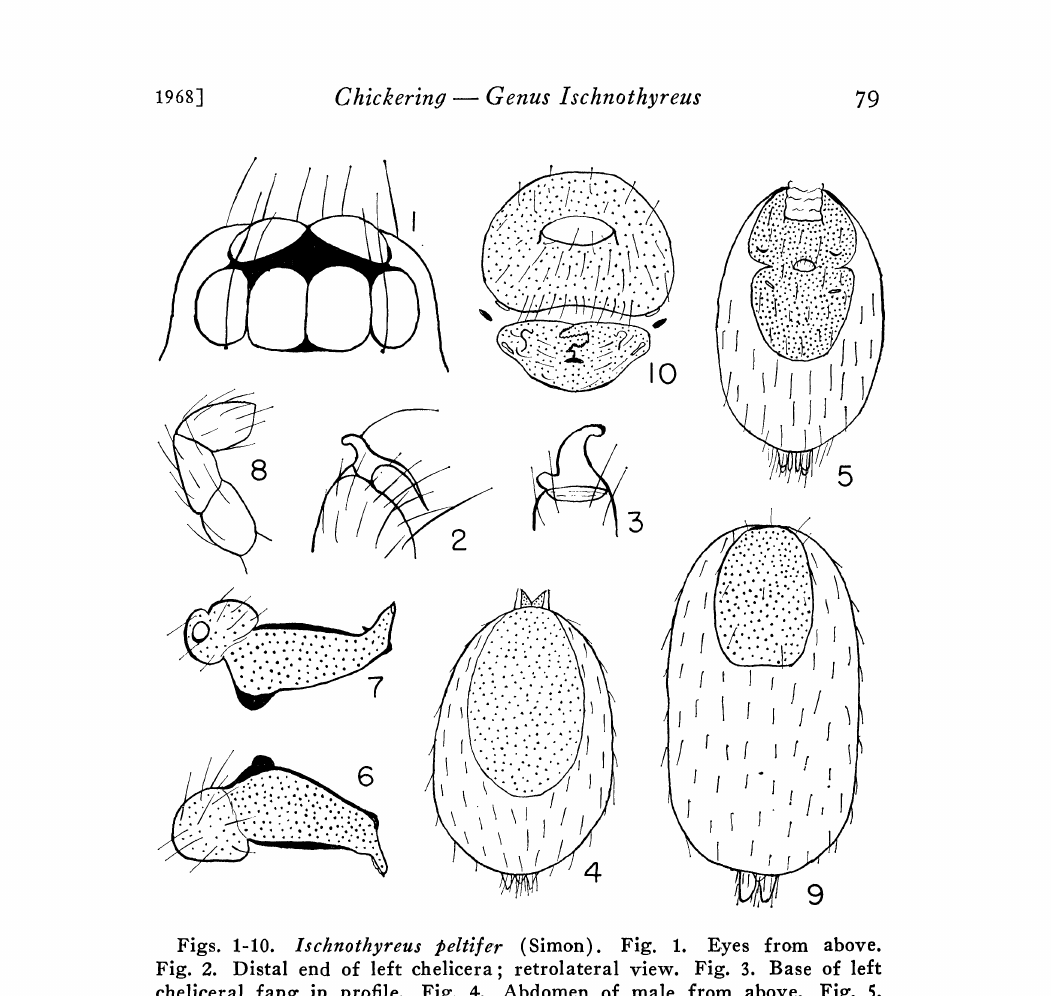
Figs. 1-10. Ischnothyreus #eltifer (Simon). Fig. 1. Eyes from above. Fig. 2. Distal end of left ehelieera; retrolateral view. Fig. 3. Base of left ehelieeral fang in profile. Fig. 4. Abdomen of male from above. Fig. S. Epigastrie and ventral seuta of male; genital aperture; from below. Figs. 6-7. Nearly retrolateral and prolateral views of left palpal tarsus,, re- spectively. Fig. 8. Left palpal femur, patella and tibia, nearly prolateral view. Fig. 9. Female abdomen from above. Fig. 10. Epigastrie and ventral seuta of female with epigynal